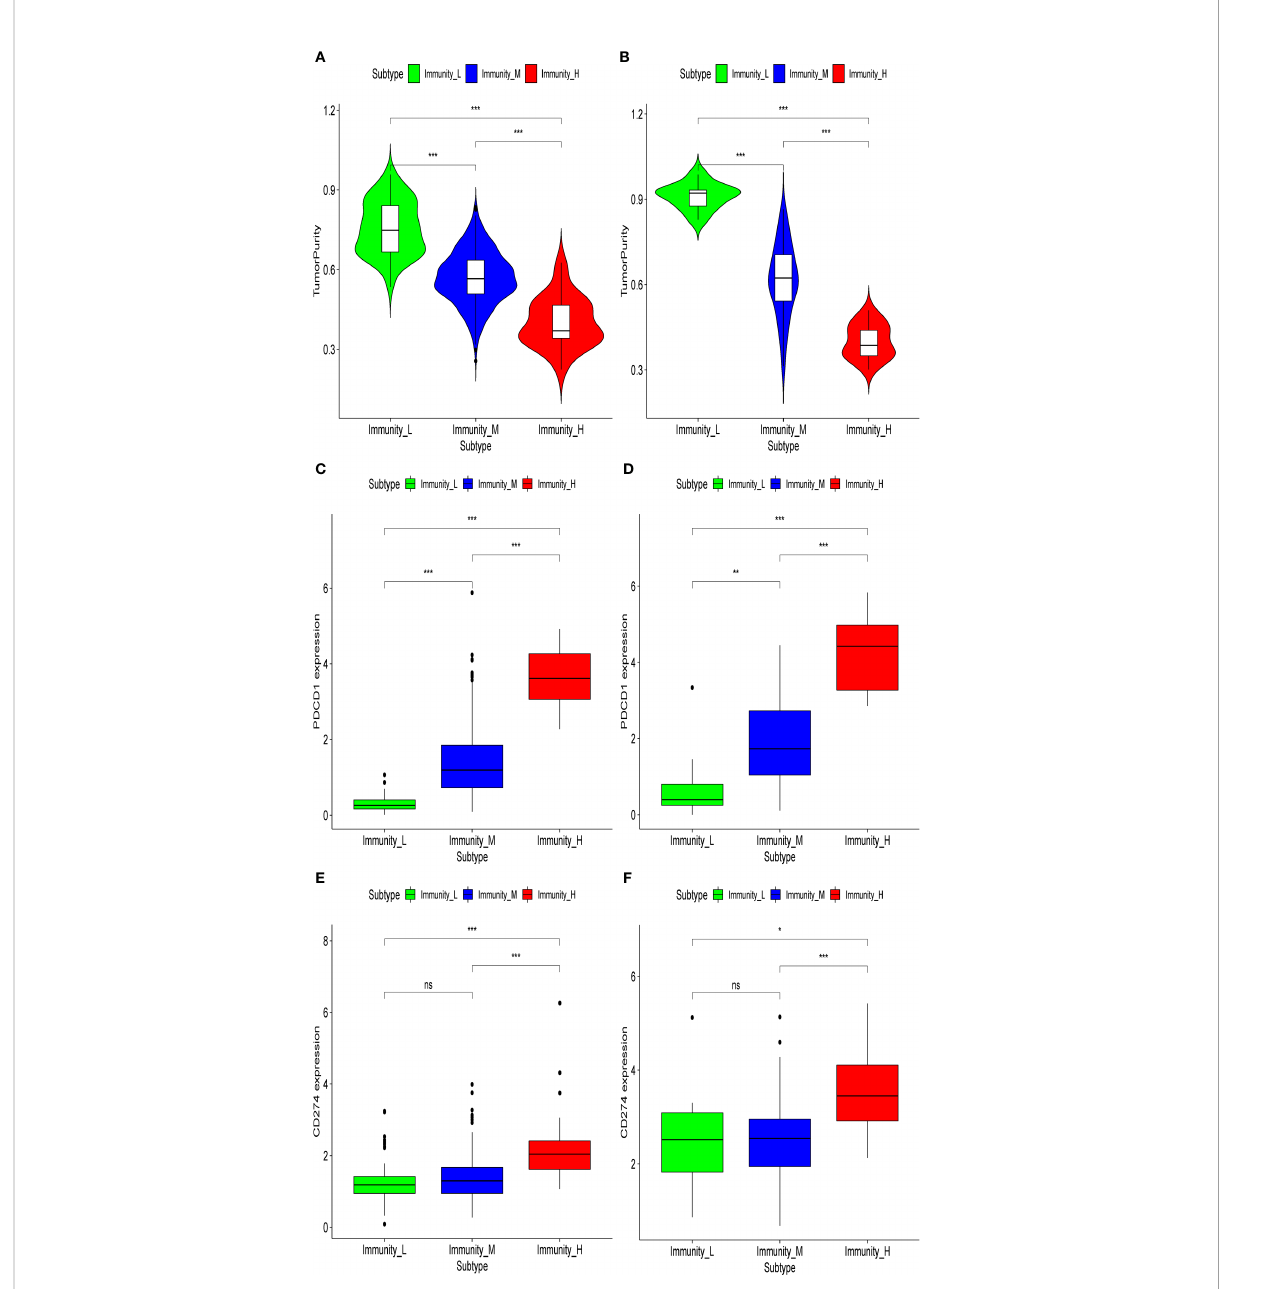
FIGURE 3 Tumor purity and expression of PD1/PD-L1 in different immunity groups in the discovery set and validation set. Tumor purity in the discovery set (A) and validation set (B) . Expression of PD1 in the discovery set (C) and validation set (D) . Expression of PD-L1 in the discovery set (E) and validation set (F) . *p < 0.05; **p < 0.01; ***p < 0.001. ns, not signi fi